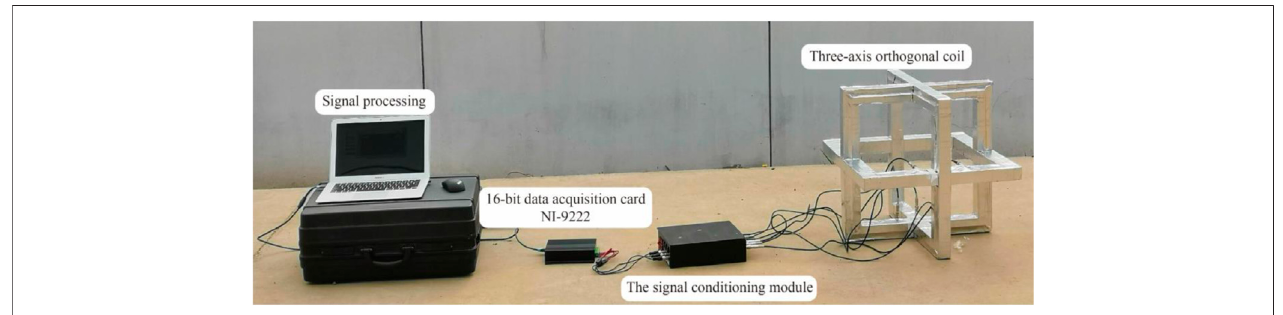
FIGURE 1 | The magnetic fi eld measurement device.